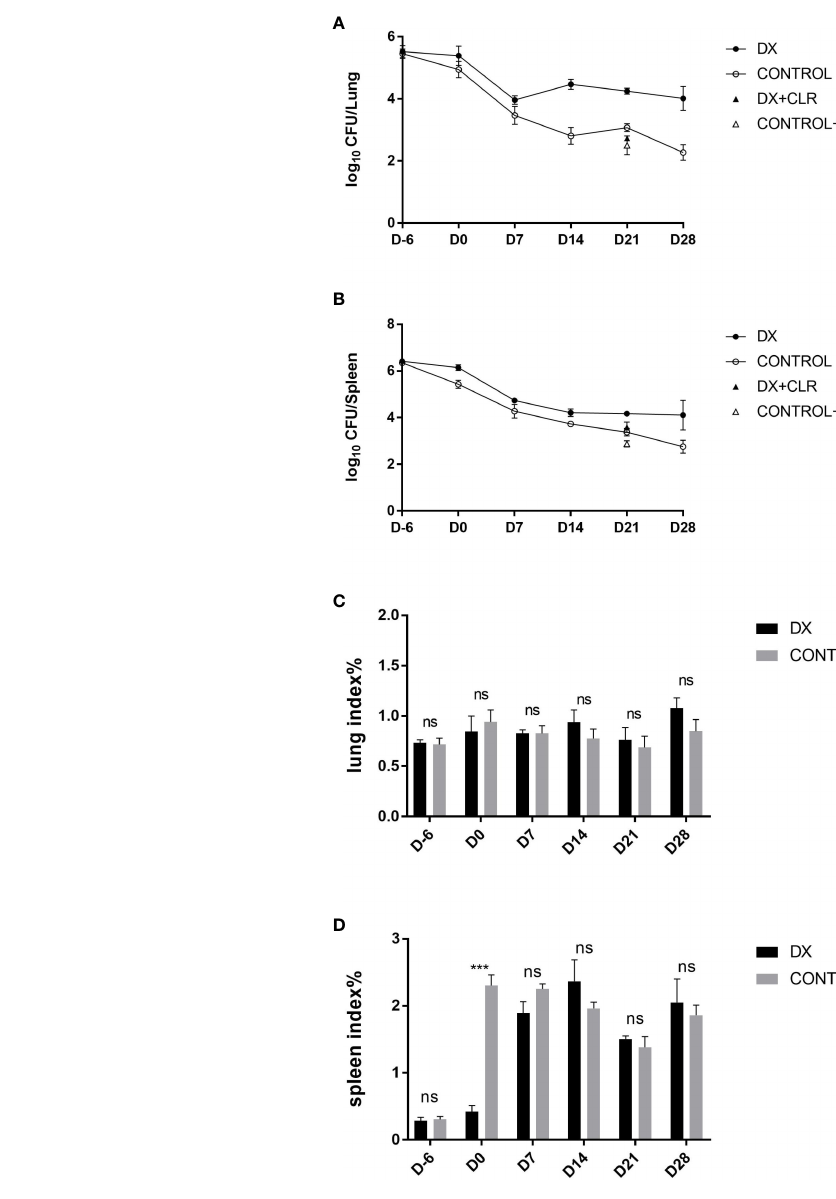
FIGURE 6 Mean number (log 10 ) of CFU and organ indices in various groups of mice infected with M. abscessus . (A, B) represent M. abscessus burdens in the lungs and spleens of mice, and (C, D) represent organ indices in the lungs and spleens of mice, respectively. The organ indices is the ratio of the organ weight to whole body weight. Plot of mean lung/spleen log 10 CFU. “ DX ” indicate mice treated with dexamethasone before and after infection, “ CONTROL ” indicate mice treated with CMC instead of dexamethasone. “ DX+CLR or CONTROL+CLR ” indicate mice given dexamethasone or CMC starting CLR treatment 7 days after infection and administered 5 days a week for a total of 3 weeks. D7, D14, D21 and D28 represents the 7th, 14th, 21st and 28th day after treatment in mice, respectively. “ ns ” indicates no statistically signi fi cant difference between the two groups.